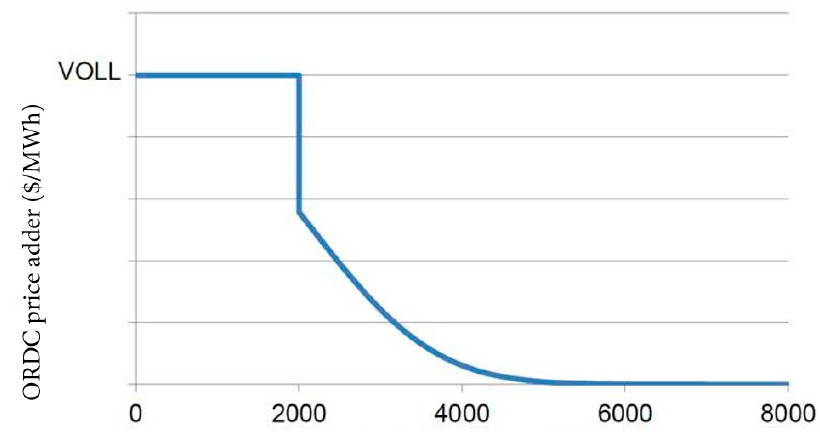
Figure 3. ERCOT’s physical reserve capability vs. ORDC price adder [6].